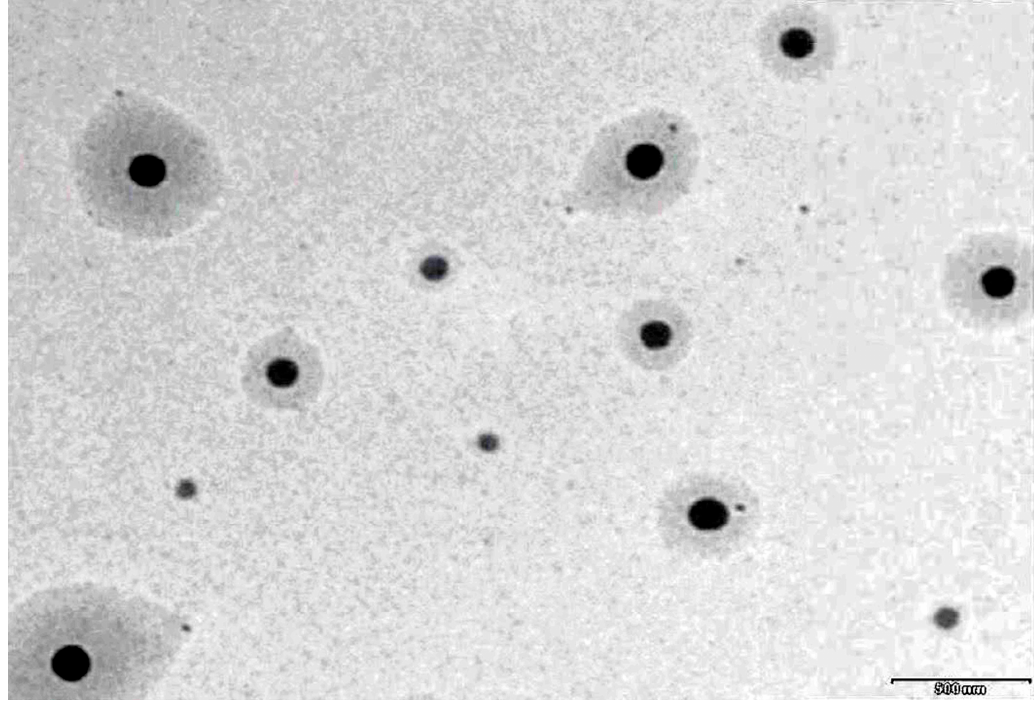
Figure 3. A representative transmission electron microscopy image of moxifloxacin nanoemulsion (MM3).